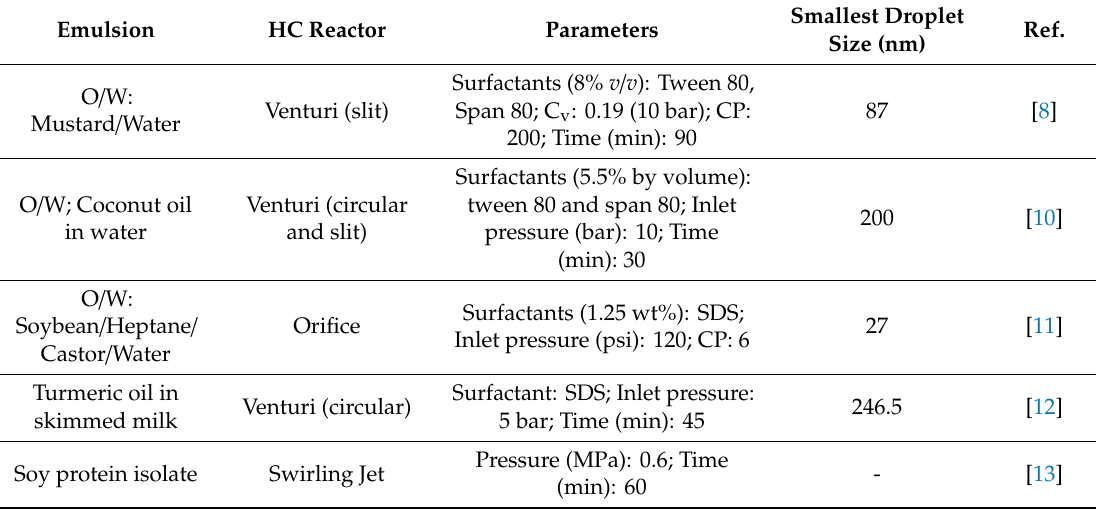
Table 1. Emulsion generation using hydrodynamic cavitating